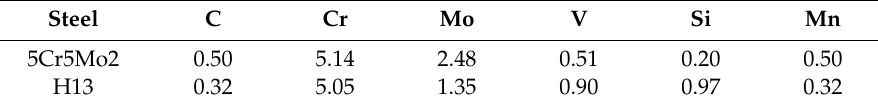
Table 1. Measured chemical composition of two alloys, in wt%, balance